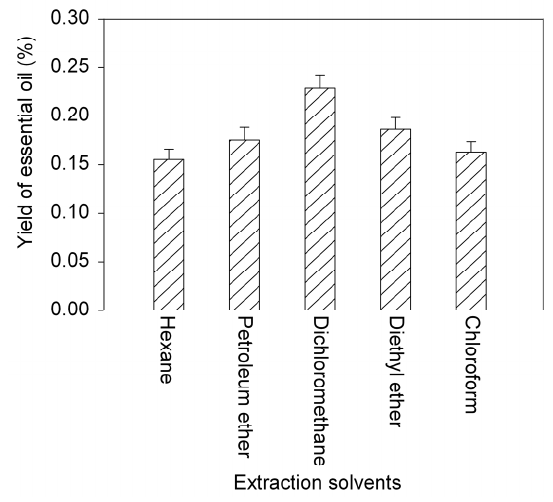
Figure 2. Effect of different extraction solvents on yields of essential oil. Error bars indicate standard deviation ( n = 3).